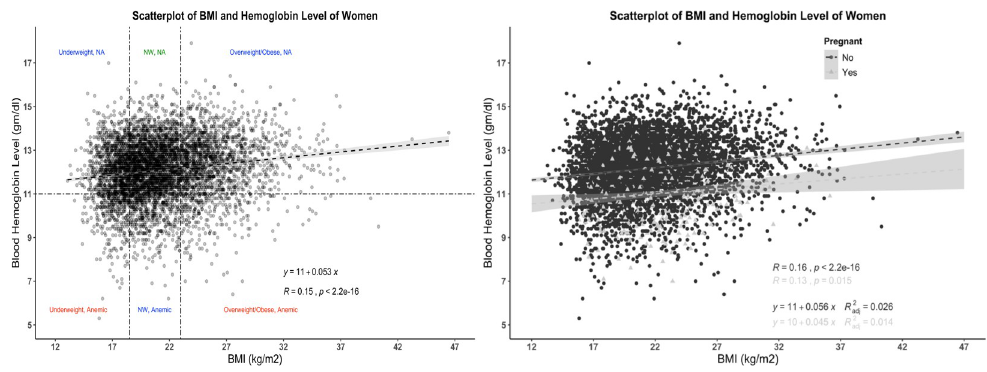
Fig 3. Association (linear) of BMI and blood hemoglobin level of women (n = 5680). Marginal density is shown for the three BMI categories (dotted vertical lines). Anemia is indicated using the cut-off < 11 g/dl (dotted horizontal line).